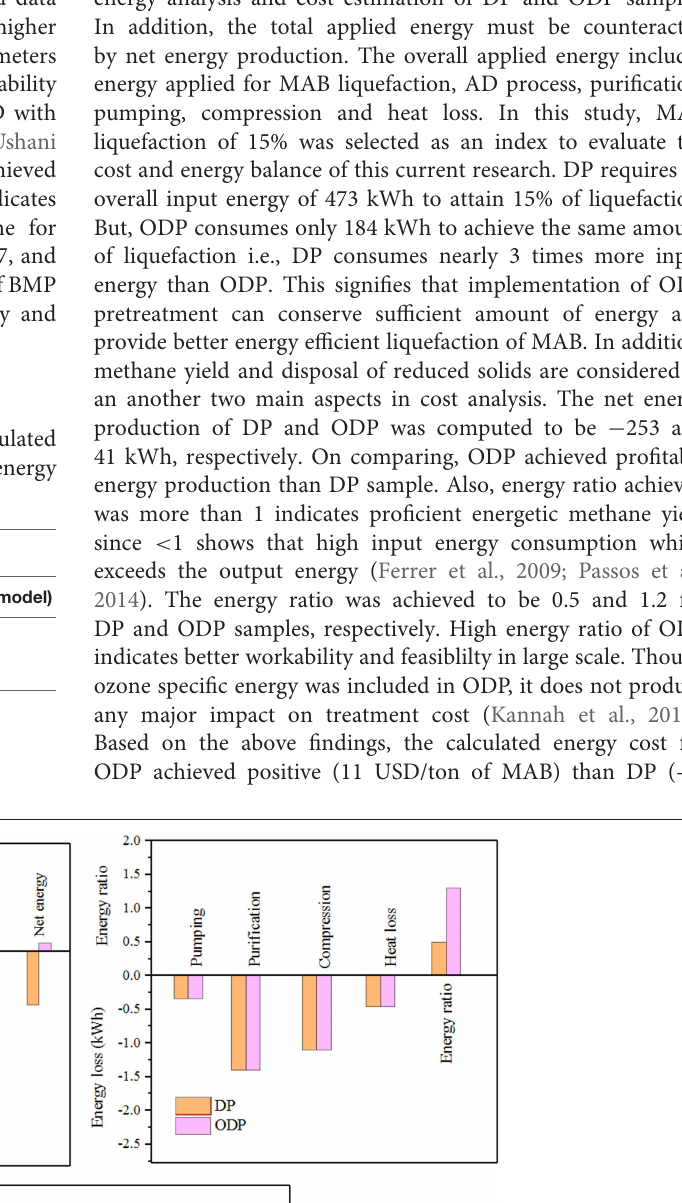
Frontiers in Energy Research |